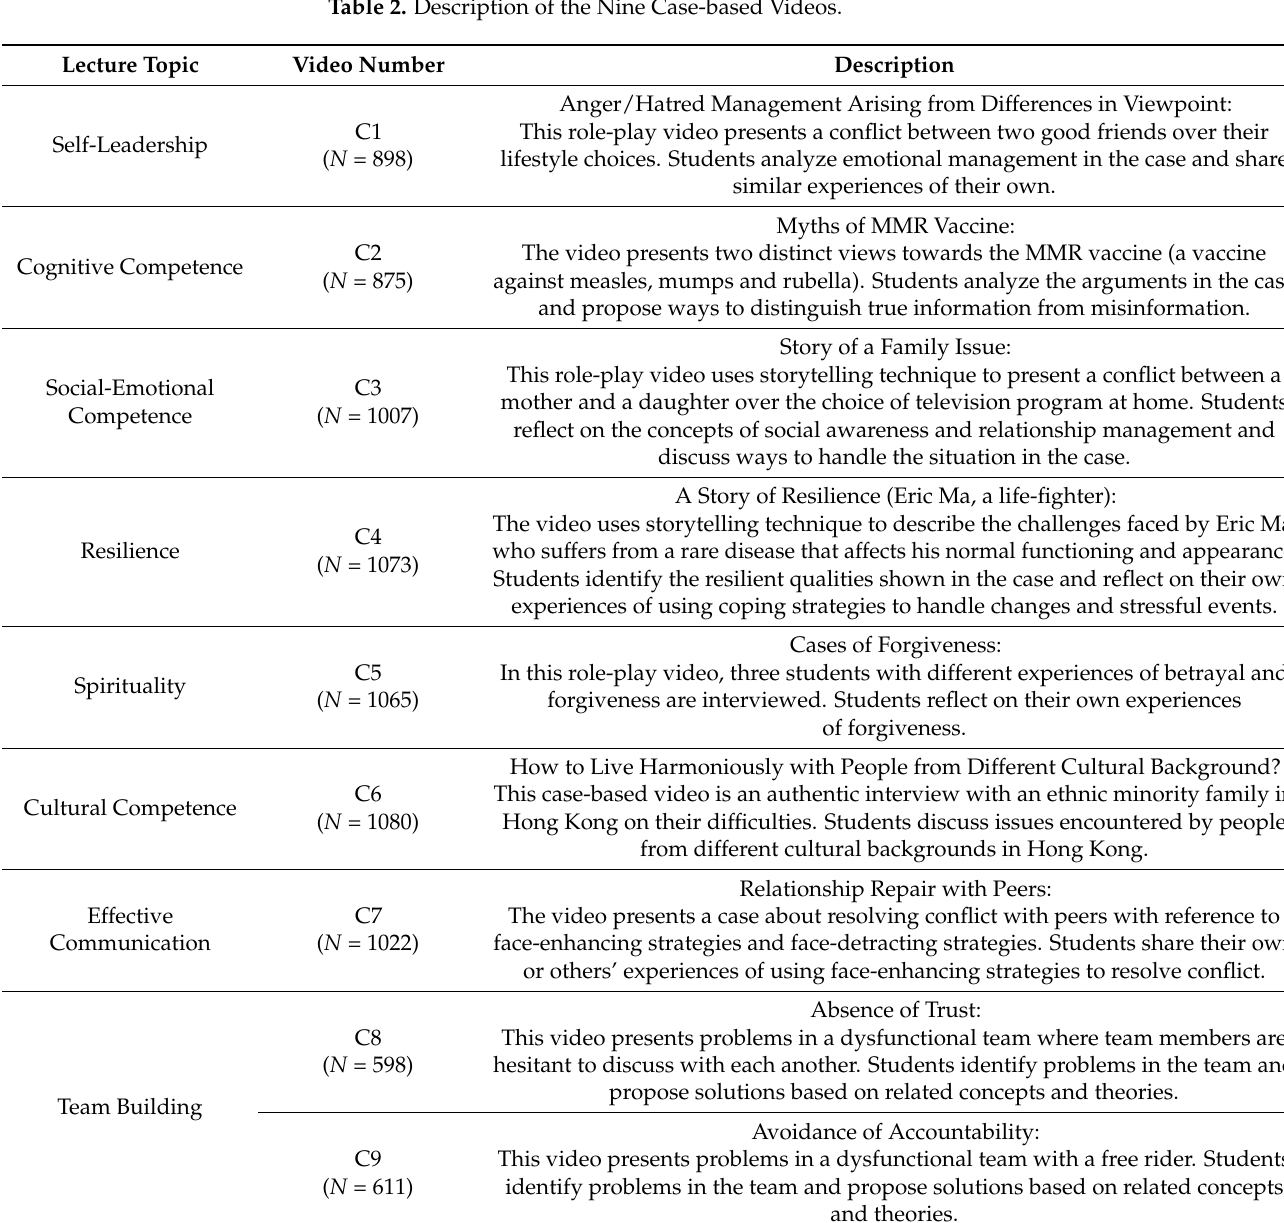
Table 2. Description of the Nine Case-based